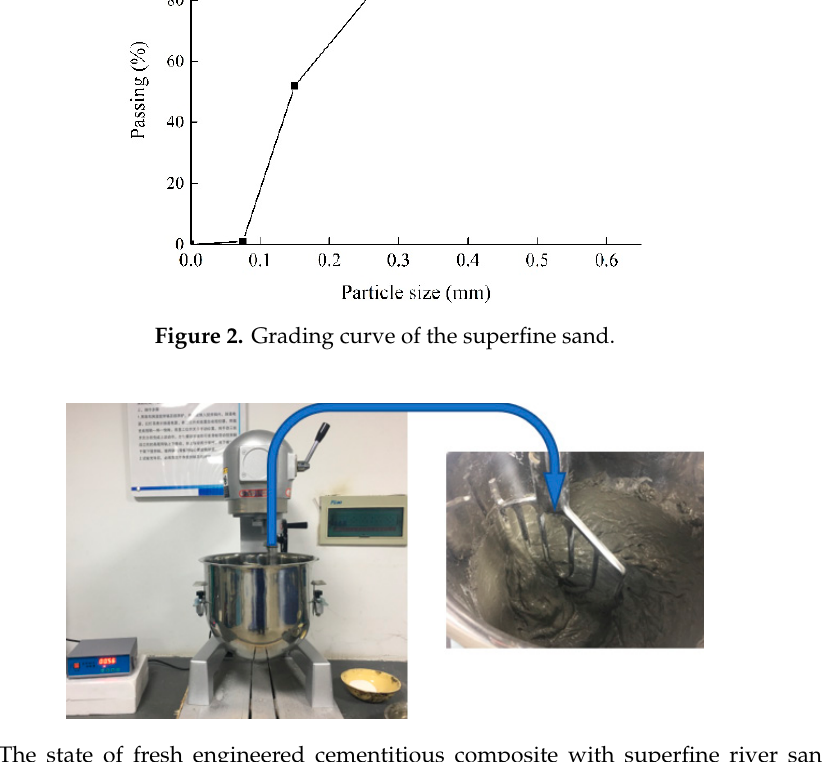
Figure 3. The state of fresh engineered cementitious composite with superfine river sand and polypropylene fiber (SSPP-ECC) after the mixing process.